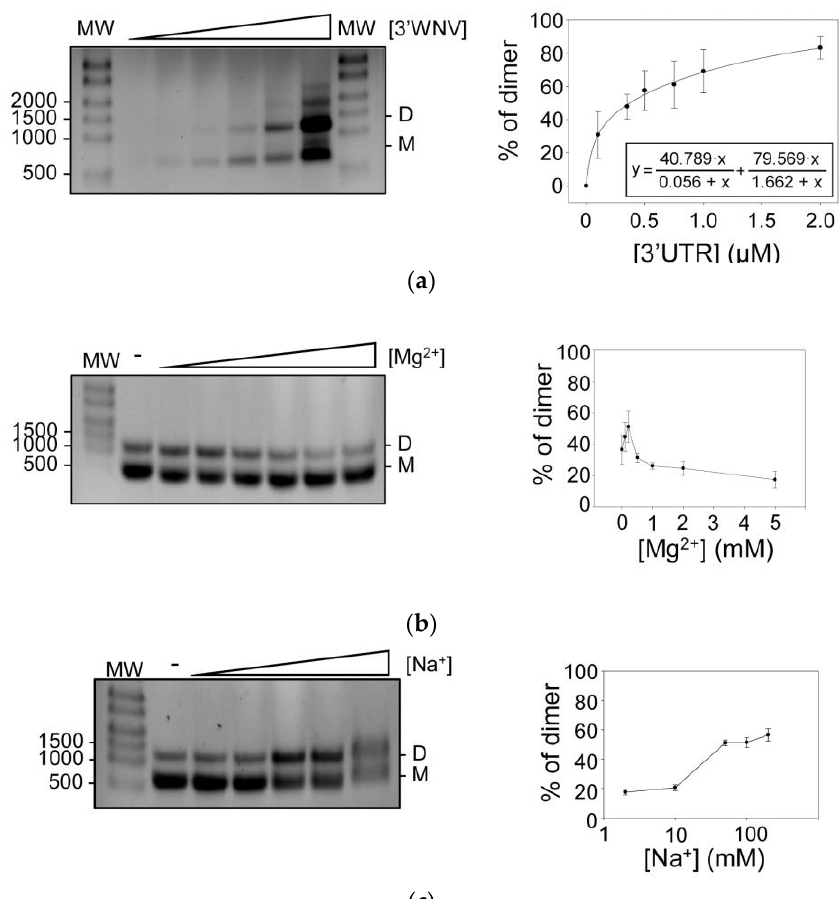
Figure 2. Dimerization of the 3′ UTR of the WNV RNA genome in a Mg 2+ - and Na + -dependent manner. ( a ) Left panel: the dimerization efficiency of 3′WNV RNA was assayed at different concentrations. Different conformers were resolved by native agarose gel electrophoresis. A representative image of these assays is shown. Relative dimer formation was quantified (right panel). Data represent the mean of at least three independent experiments ± standard deviation. ( b ) and ( c ) Mg 2+ and Na + dependence for dimer formation. Dimerization assays were performed in the presence of increasing concentrations of Mg 2+ ( b ) or Na + ( c ) ions. Conformers were resolved as noted above (left panels). Relative dimerization was quantified in order to establish the optimal ionic conditions. Data represent the mean of at least three independent experiments ± standard deviation ( b ). M, monomer; D, dimer.